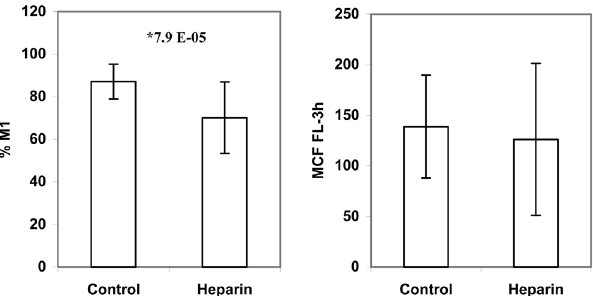
Figure 4. Heparin sulfate effects on yeast surface hydrophobicity. Twelve yeast strains were pre-incubated at 25 8 C with 100 m l heparin sulfate or with S-PBS, before bead-binding assay. The percentage M1 (average of 12 strains) was reduced, and many yeast strains showed reduced relative fluorescence (MCF-F13-h), although on average the parameter was not significant. Asterisk indicates p 5